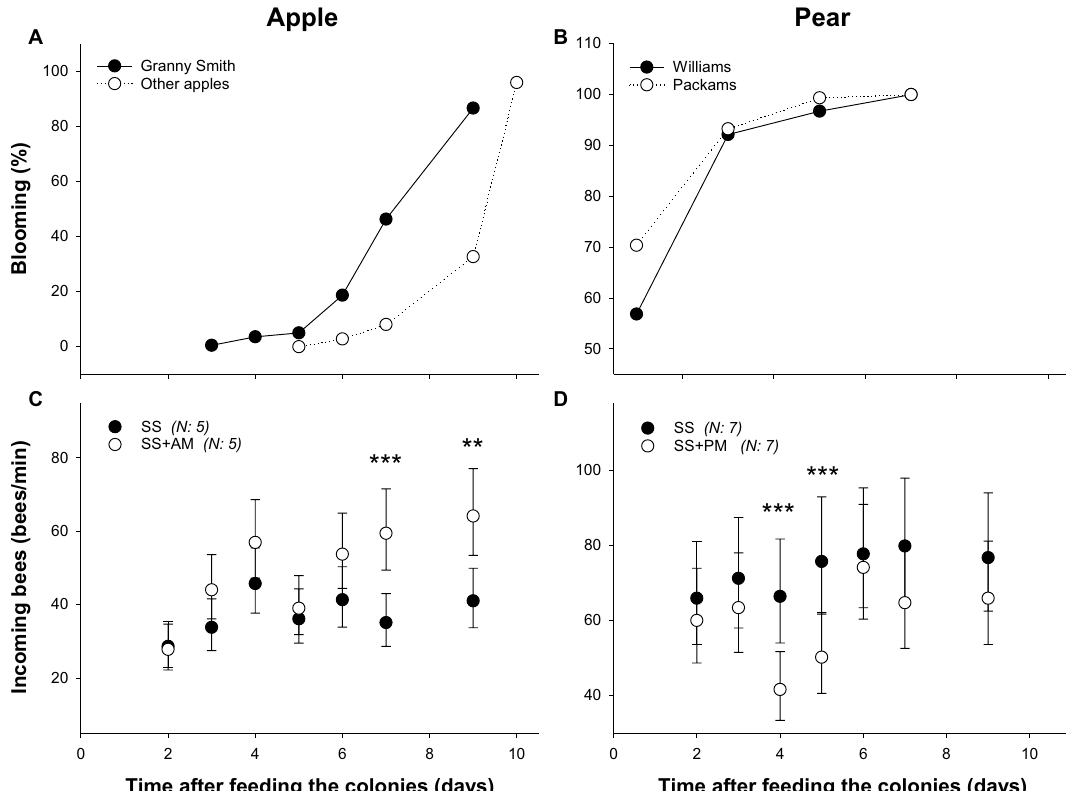
Figure 3. Effect of the mimic odours on the activity of colonies that pollinate apple or pear trees. Percentage of blooming of the dominant variety of apple tree ( A ) or pear trees ( B ) during the experimental period. Colonies were fed either unscented sucrose solution (SS) or apple mimic-scented sucrose solution (SS + AM) ( C ) or pear mimic-scented sucrose solution (SS + PM) ( D ). Incoming bees were calculated as the counts after the offering of the solutions (2, 3, 4, 5, 6, 7 and 9 days). Asterisks indicate significant differences between the specified treatments (***, p < 0.001; **, p < 0.01). Circles indicate the mean values and bars show the 95% confidence intervals. Numbers between brackets indicate the number of colonies monitored per treatment. Package ‘glmmTMB’ version 1.1.4. https:// github. com/ glmmT MB/ glmmT